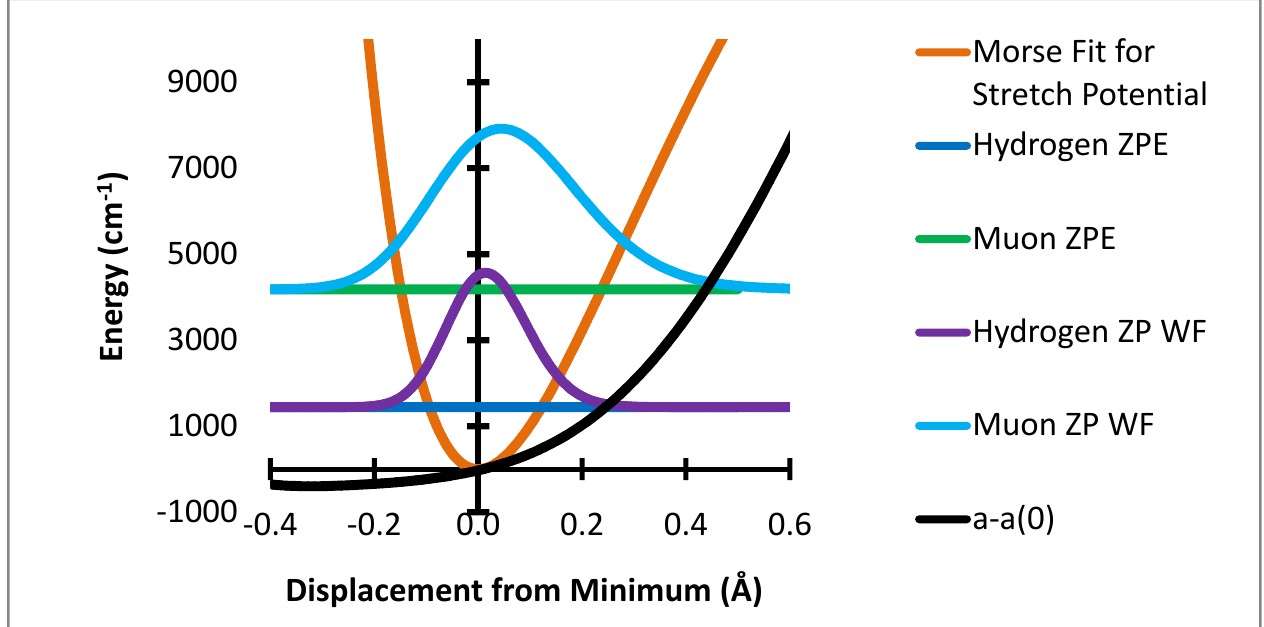
Figure 1. Stretching potential energy with zero point energy levels and probability distributions for H and Mu and variation of a-a(0) Gauss × 10 5